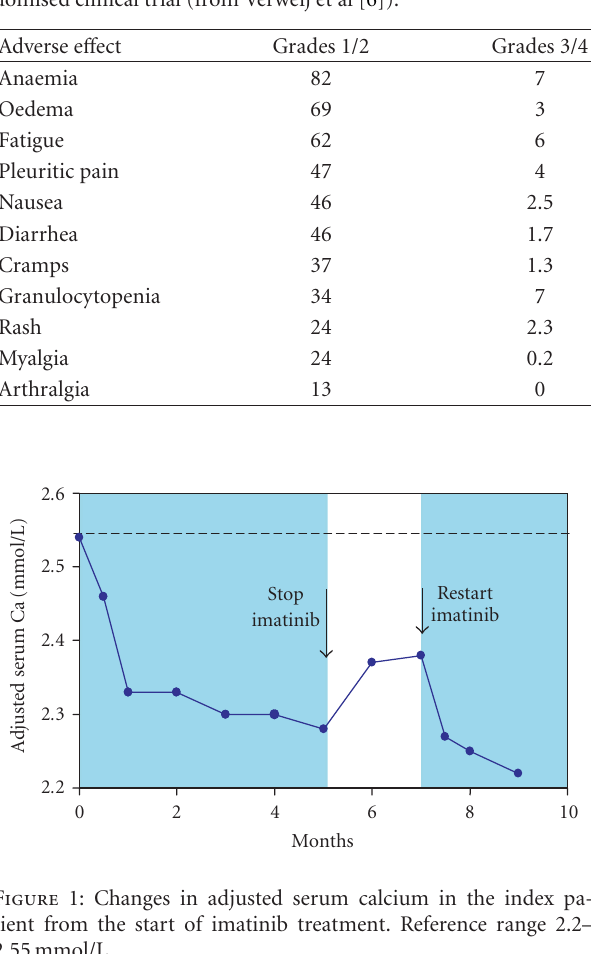
Table 1: Incidence of common adverse e ff ects (%) in patients re- ceiving imatinib 400mg/day for GIST, among 470 patients in a ran- domised clinical trial (from Verweij et al [6]).